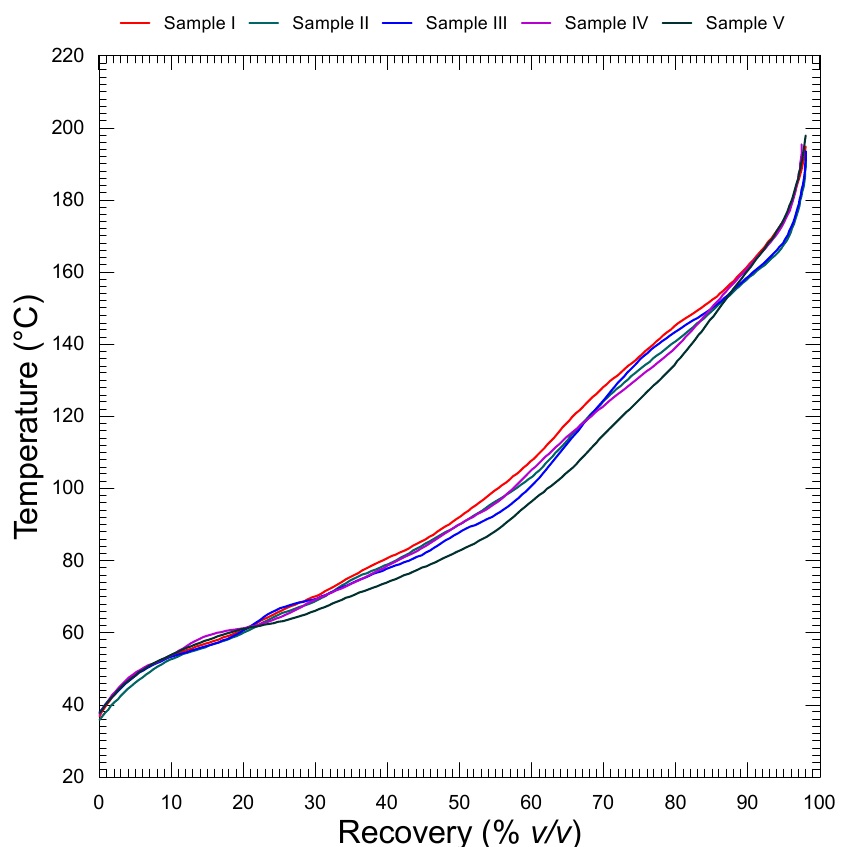
Figure 5. Distillation curves of base fuels.